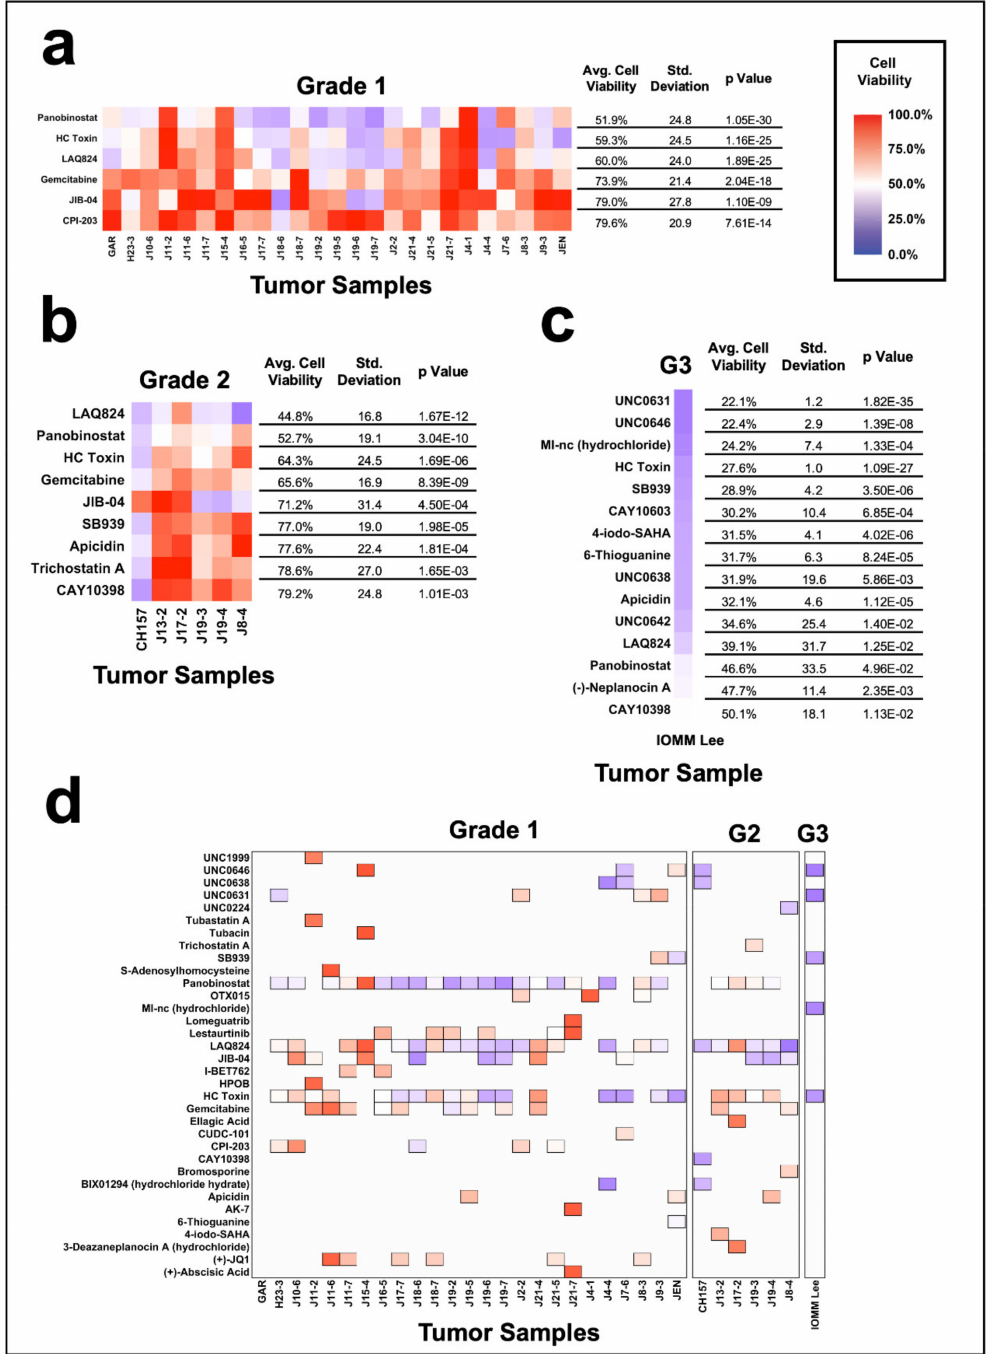
Figure 3. Comparison of the meningioma cohort by tumor grade. Heat maps displaying the broadly most effective compound separated by tumor grade: ( a ) grade 1 tumors, ( b ) grade 2 tumors, and ( c ) grade 3 tumors, denoted as “G3”. Broadly effective compounds for each grade are identified as compounds that reduce the average cell viability of the group to 80% or less and have a p value of less than 0.05. Heat maps were limited to the top 15 most effective compounds when applicable. ( d ) Heat map of the top five most effective epigenetic compounds, faceted by grade 1, grade 2 (denoted as “G2”), and grade 3 (denoted as “G3”) meningiomas. The top five compounds are displayed as filled tiles in the heat map, while compounds that were not in the top five remain as white